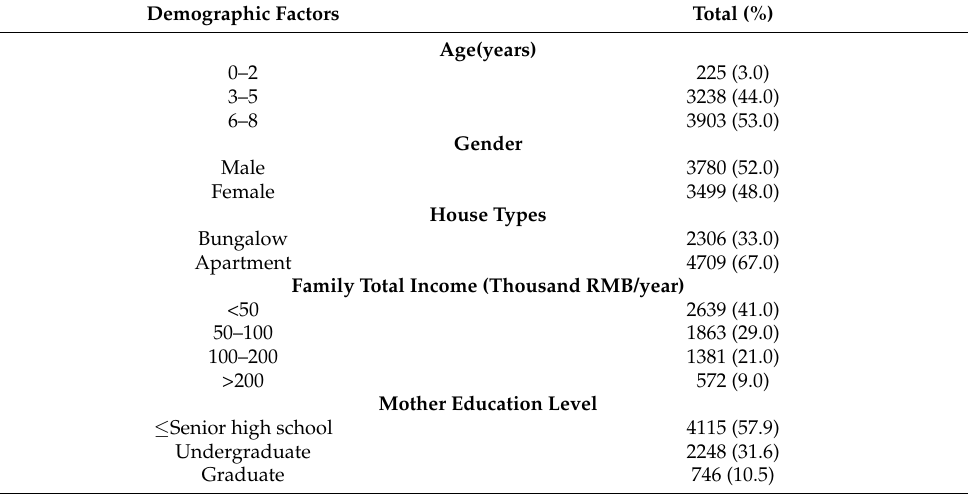
Table 1. Demographic information, and health outcomes of investigated